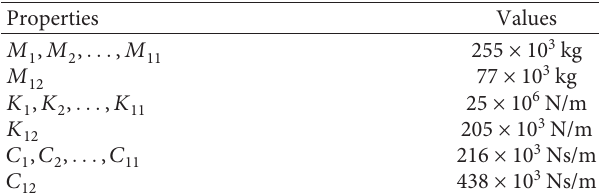
Table 1: The physical and geometrical specifications of the studied building.